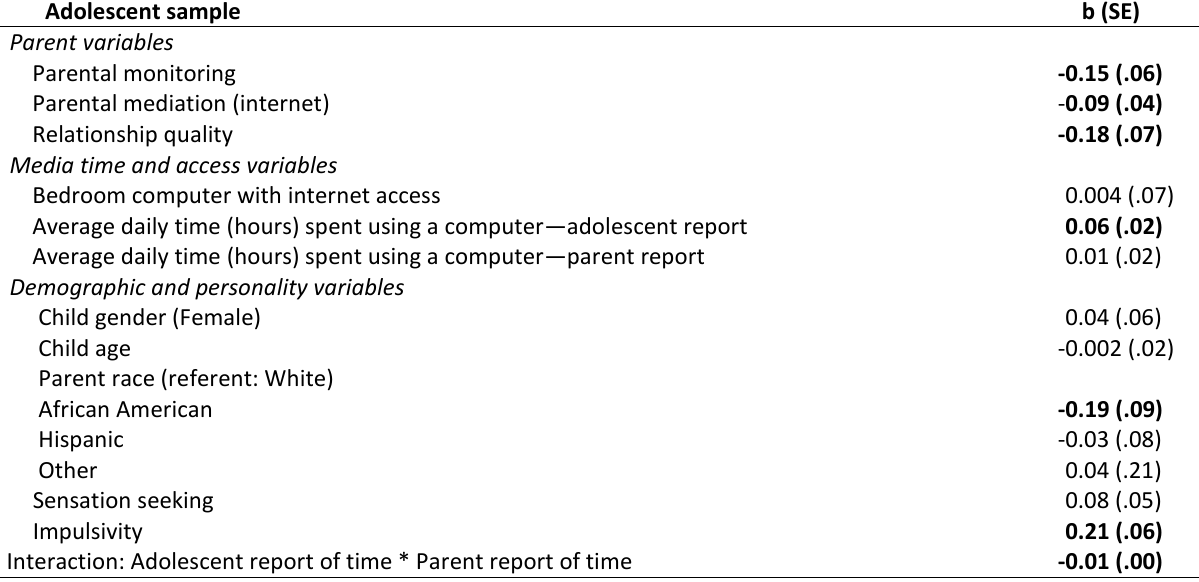
Table 3 . Effects of parental environment and media access on problematic internet use among 12–17 year old adoles- cents